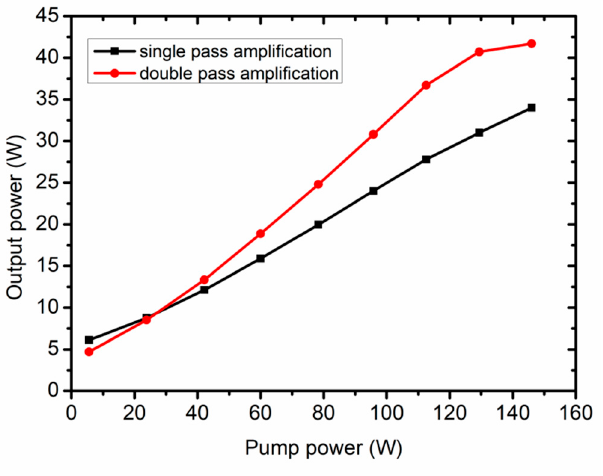
Figure 4. Output power of single ‐ and double ‐ pass amplification of the second stage SCF amplifier.